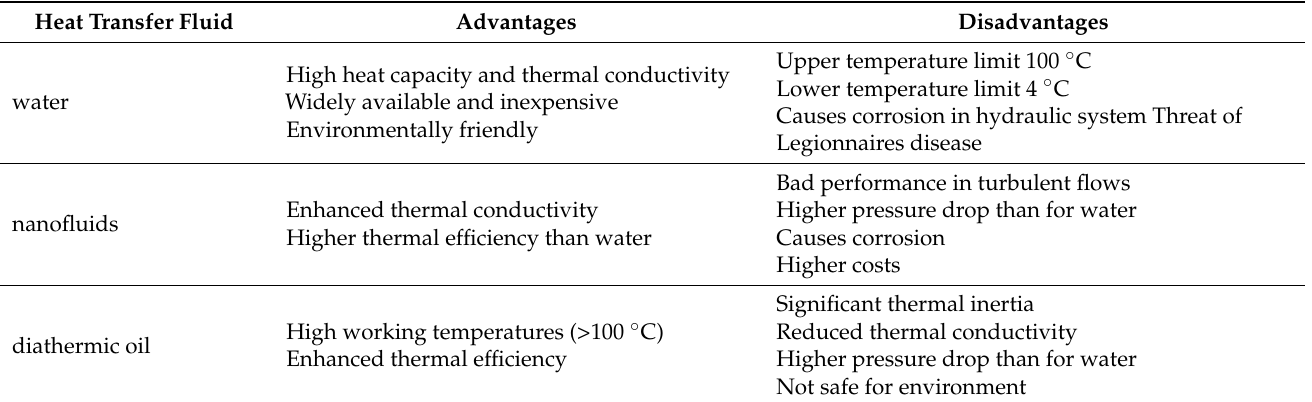
Table 3. Advantages and disadvantages of liquid coolants used in CPVT systems. Prepared on the basis of [3,22].